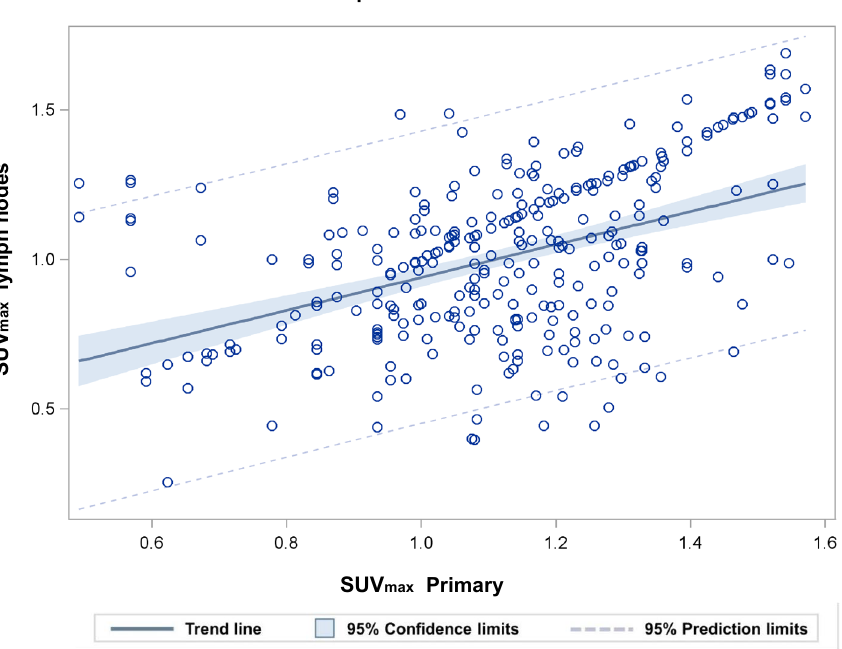
Figure 3. Fit plot for SUV max of primary tumours and lymph nodes. The figure shows the dependence of the SUV max values of EBUS-positive LNs on the SUV max values of the primary tumours. Covariance plot adjusted for the echelon-effect on the SUV max . The R-value for the fit is 0.4496 = 0.45.